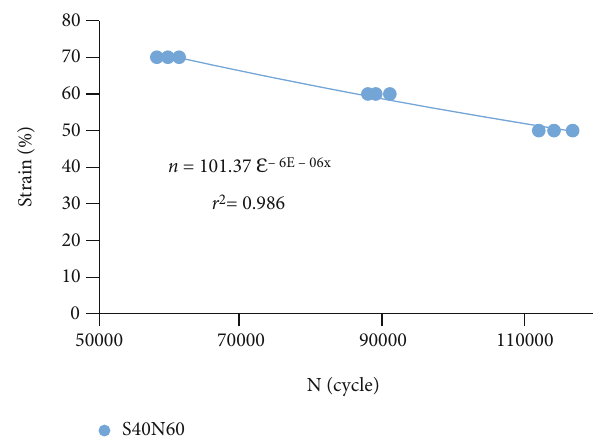
Figure 5: Fitted curve error in the strain-life diagram of S40N60 compound.